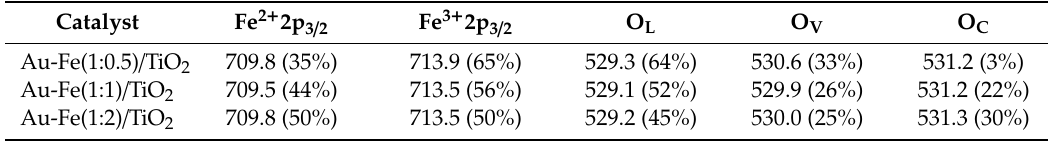
Table 2. XPS analyses of Au, Fe, and O on the Au-FeO x /TiO 2 catalyst surfaces. The values in parentheses are the concentrations of the corresponding species. Binding energies are given in eV.